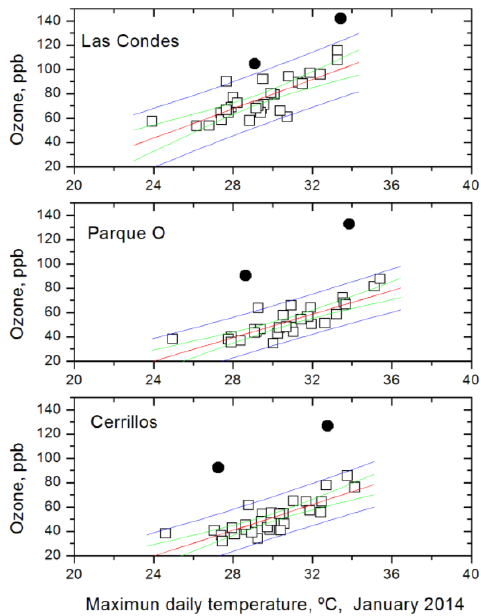
Figure 7. Lineal relationship between Ozone maximum one hour average and daily maximum temperature. (□) with Confidence band and Prediction band (95%). Measurements in days with nearby fires (▪).